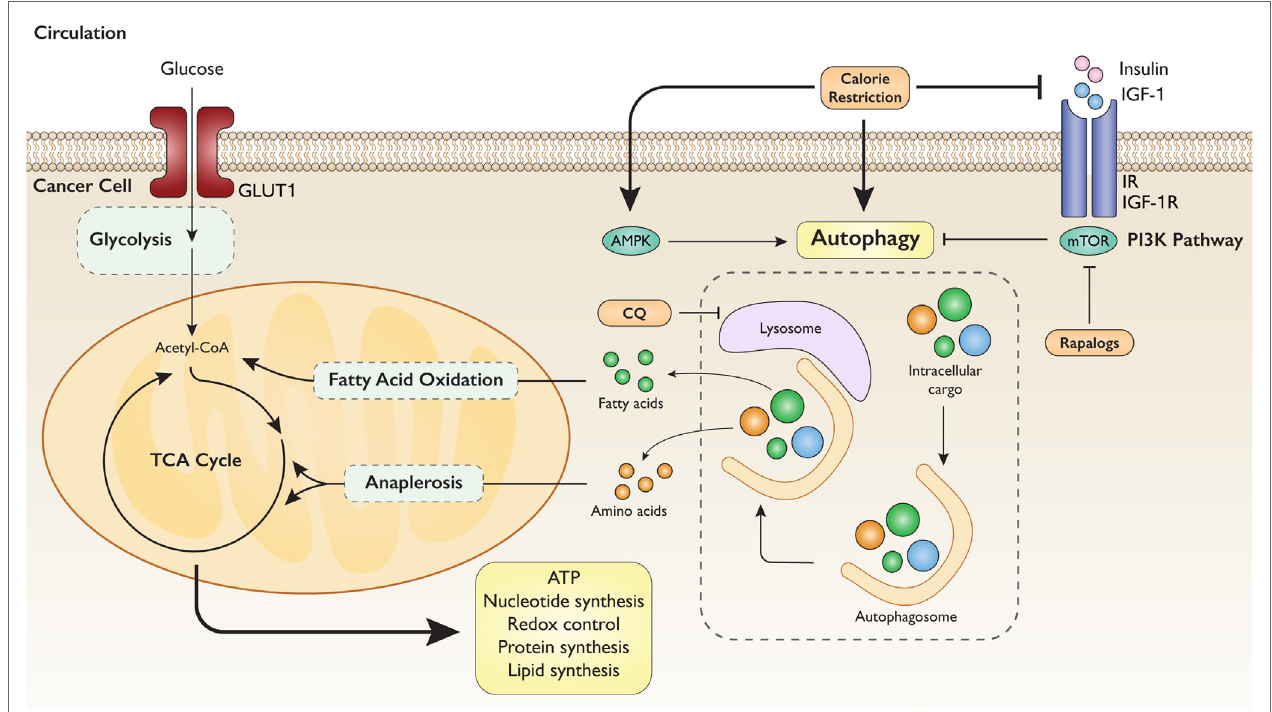
FiGURe 3 | Autophagy mediates intrinsic metabolic response to extrinsic nutrient signals. Model illustrating the tumorigenic aspect of autophagy-mediated metabolic reprogramming. Nutrient deprivation signals the degradation of intracellular cargo to utilize constituent substrates for energy and biosynthesis. Calorie restriction strongly induces autophagy through several mechanisms. Simultaneous inhibition of autophagy with CQ (chloroquine) exerts sufficient metabolic stress to block